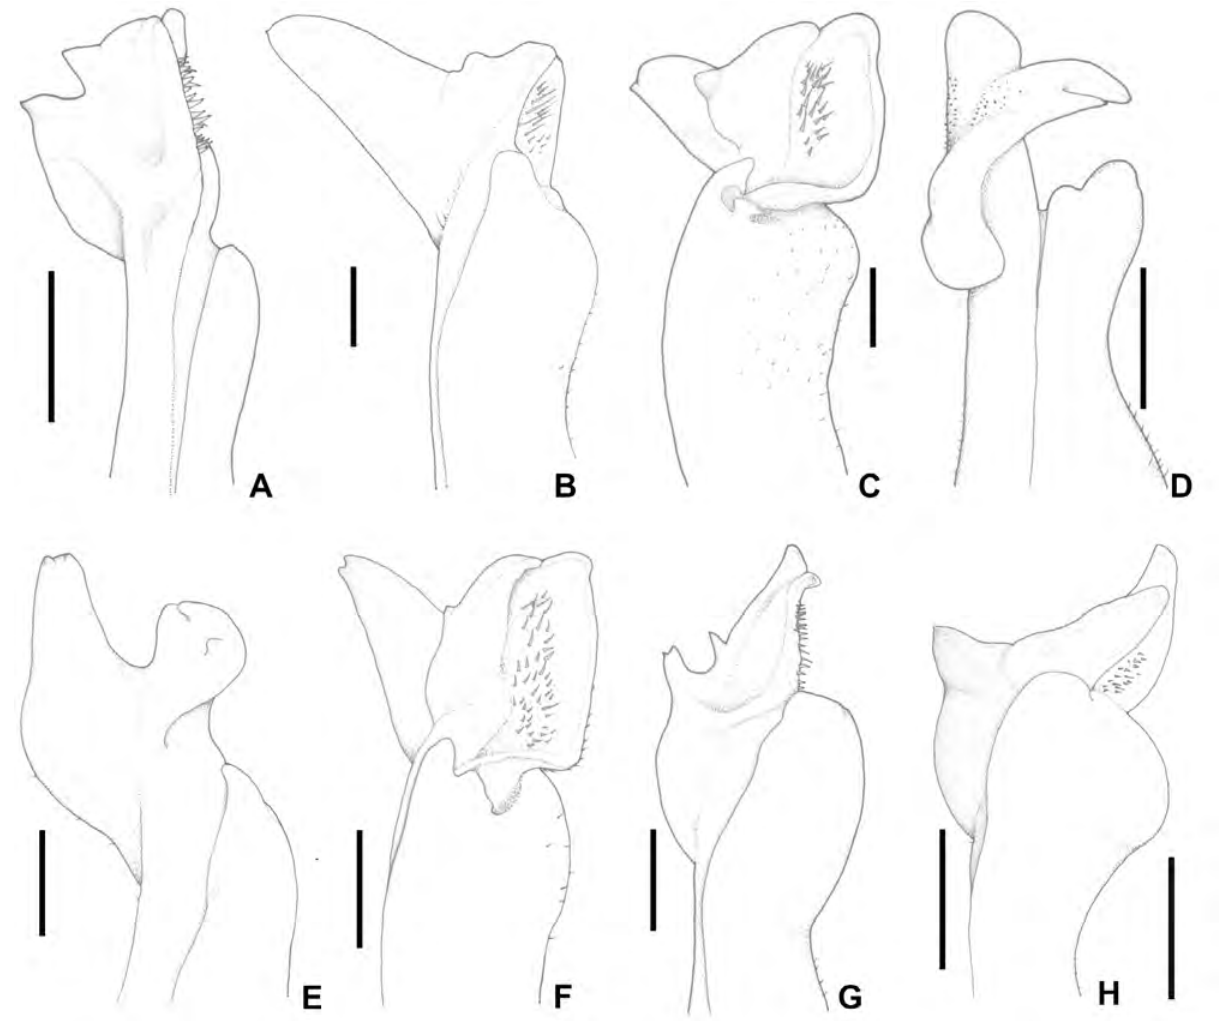
Figure 1. Male first gonopod, left side, distal part, of the pseudothelphusid crabs from Roraima. A, Fredius beccarii (Coifmann, 1939), mesio-caudal view, INPA 1895; B, Fredius estevisi (Rodríguez, 1966), mesio-caudal view, INPA 839; C, F. estevisi , latero-caudal view, INPA 839; D, Fredius fittkaui (Bott, 1967), mesial view, INPA 1338; E, Fredius platyacanthus Rodriguez and Pereira, 1992, mesial view, INPA 840; F, F. platyacanthus , lateral view, INPA 840; G, Fredius stenolobus Rodríguez and Suárez, 1994,